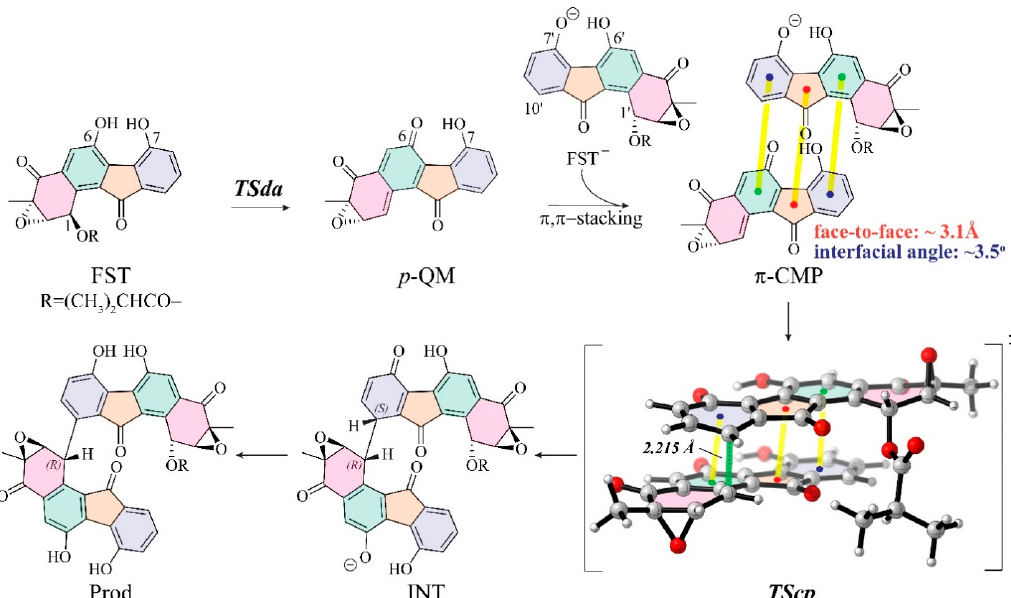
Figure 2. The proposed reaction mechanism for fluostatin conjugation in this work. (FST, fluostatin D; FST − , fluostatin anion; TSda, transition state of deacyloxylation; p -QM, para -quinone methide; π -CMP, the low-energy π – π stacking pre-reaction complex; TScp, the low-energy transition state of C-C coupling; INT, the immediate product of TScp; Prod, Difluostatin E.)